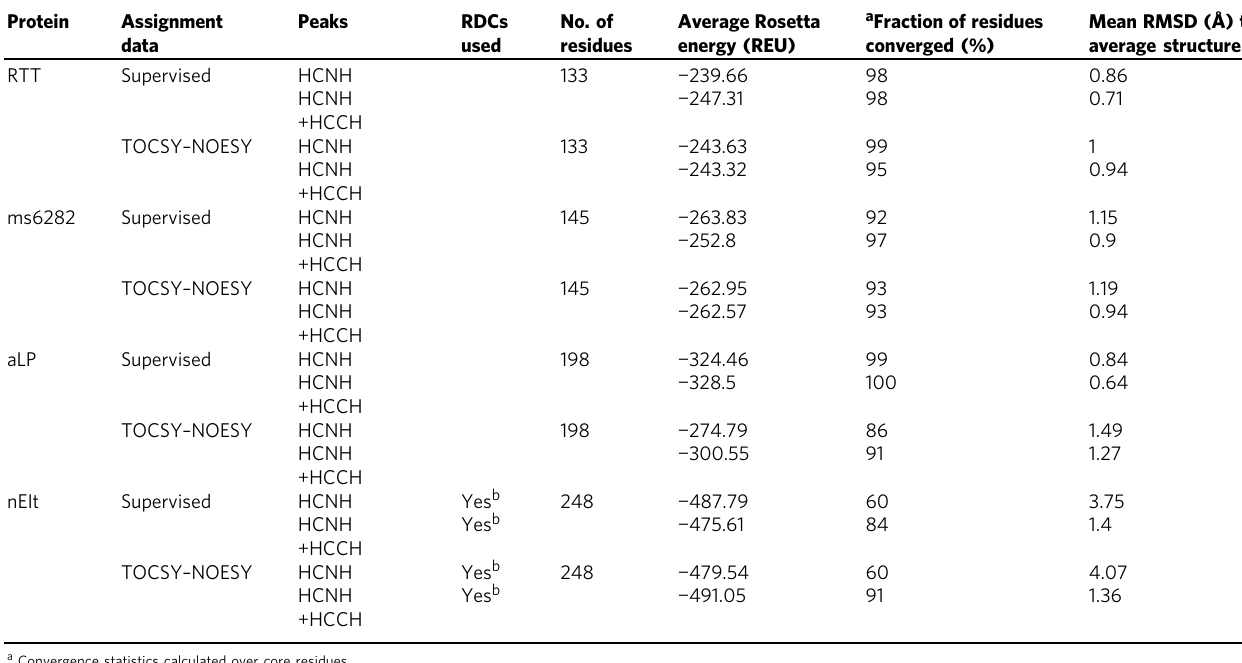
Table 1 Statistics of autoNOE-Rosetta structural ensembles computed using supervised and automated 4D-CHAINS